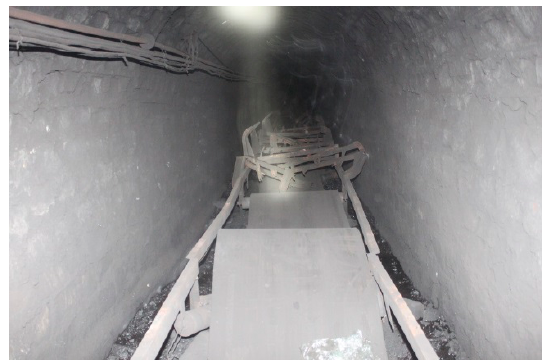
Figure 1. Steel cord conveyor belt break scene.